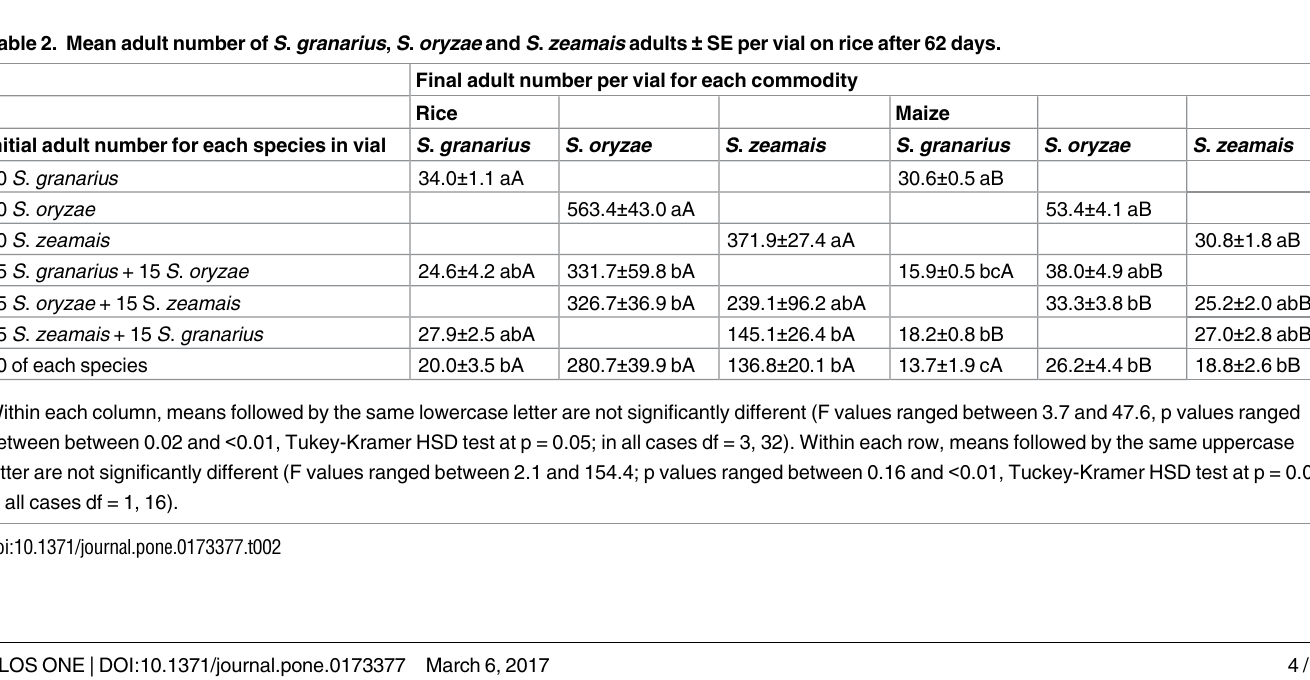
Table 2. Mean adult number of S . granarius , S . oryzae and S . zeamais adults ± SE per vial on rice after 62 days.